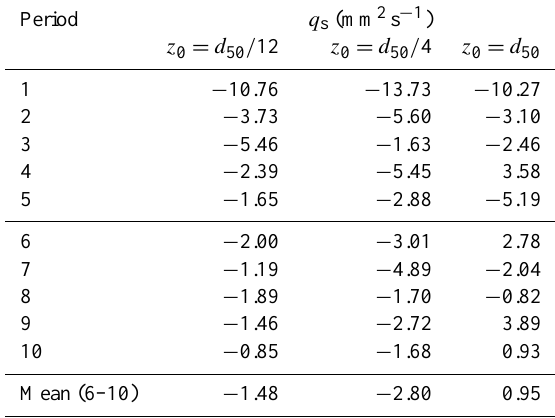
Table 2. Period- and ripple-averaged suspended sediment flux (as compared to the experimental result of − 10 . 6 ± 1 . 7mm 2 s − 1 ) for varying surface roughnesses for each period of oscillation (i.e., the mean over 5s) of the